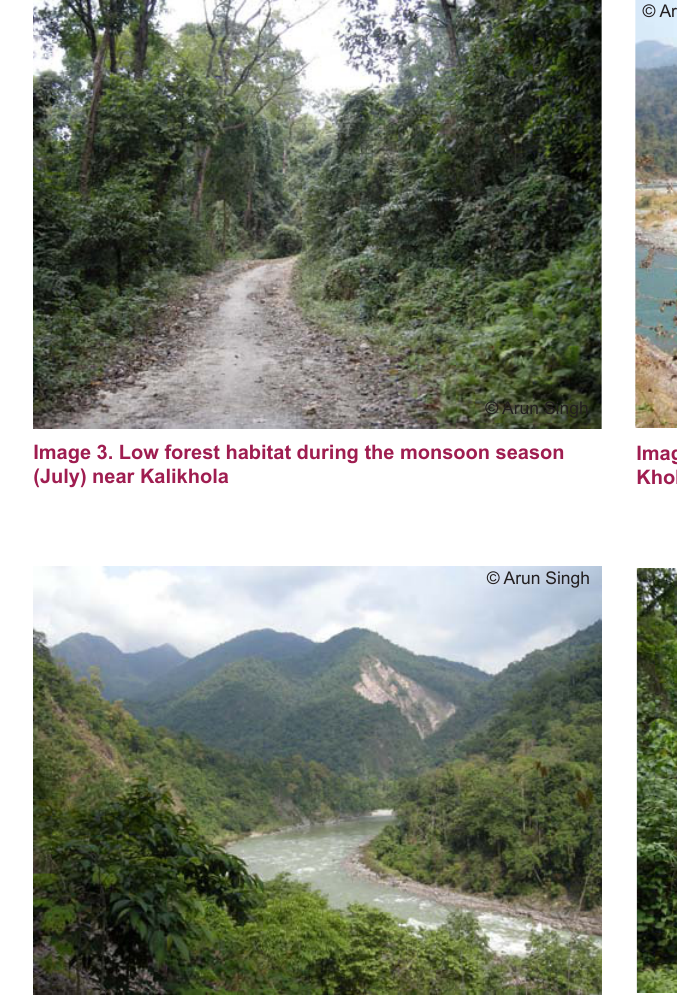
Image 5. Sankosh River flowing further up from the dam site close to Huma